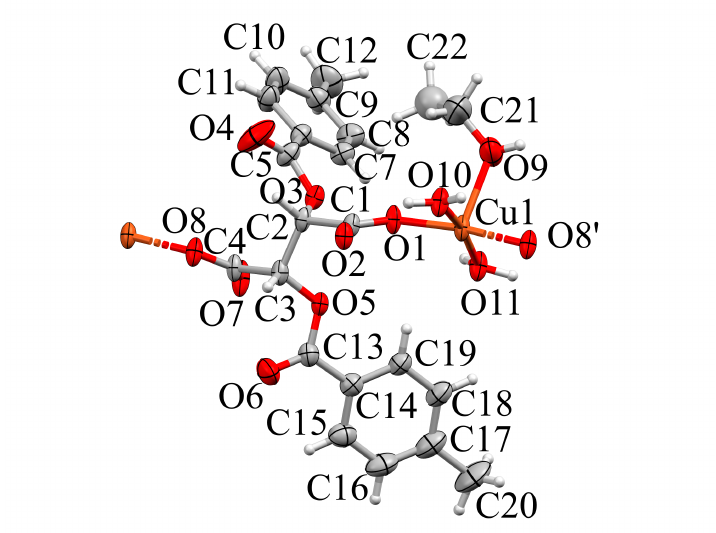
Figure 11. Expanded asymmetric unit of 3a (Mercury, [42]). Non-hydrogen atoms in the complex are shown as ellipsoids (70% probability), H as spheres with fixed radius of 0.15 Å. The disordered carbon Atom C22 was refined isotropically. Coordination distances (Å): Cu1–O10 = 1.939(2), Cu1–O1 = 1.950(2), Cu1–O8 (cid:48)(cid:48) = 1.958(2), Cu1–O11 = 1.961(3), Cu1–O9 = 2.227(3). Symmetry codes: ( (cid:48) ) = x + 1, y , z , ( (cid:48)(cid:48) )= x − 1, y , z